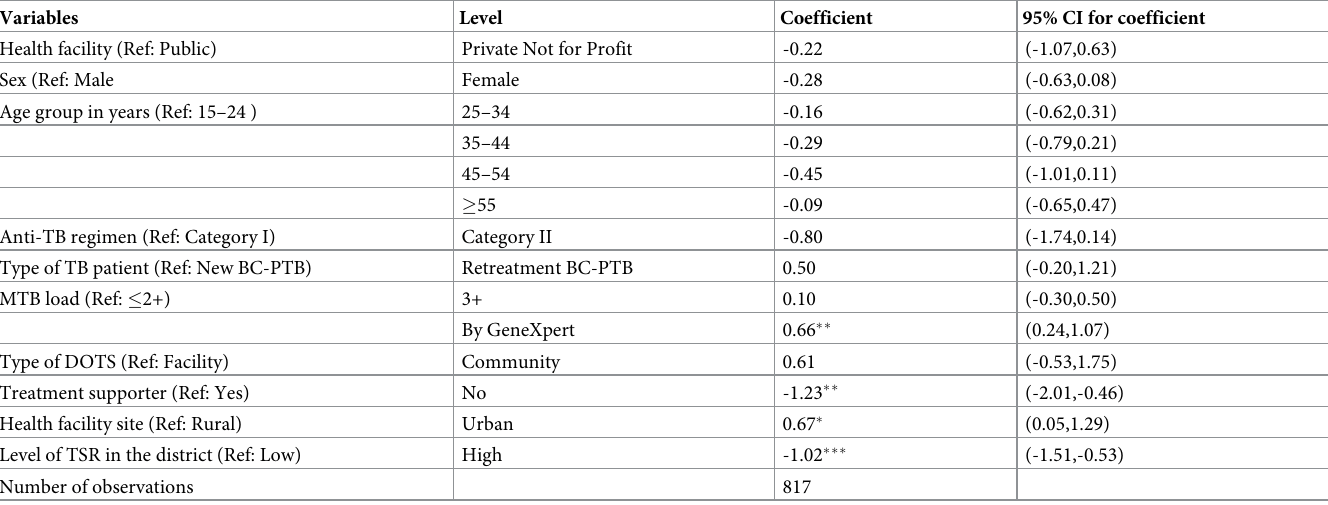
Table 3. Propensity score estimation results in a logit model.